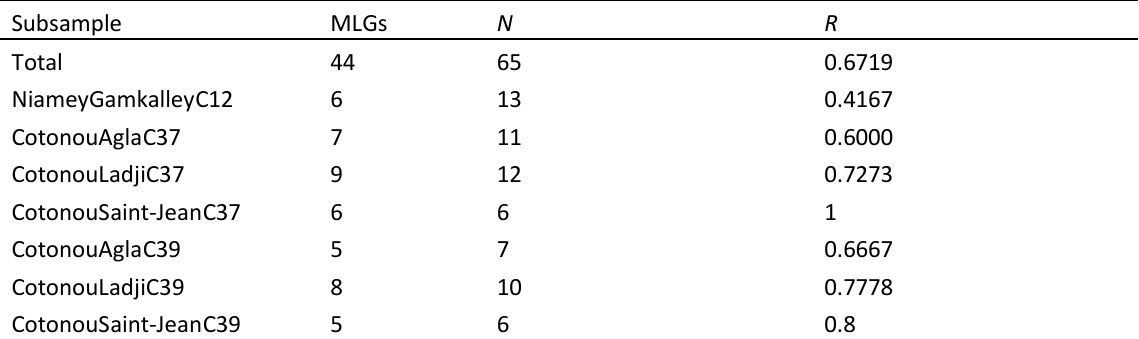
Table 5: Number of multilocus genotypes (MLGs) found for Trypanosoma lewisi from Niamey cohort 12 (C12) and Cotonou cohorts 37 (C37) and 39 (C39) from different neighborhoods (Agla, Ladji, Saint- Jean); subsample sizes ( N ); and MLG diversity ( R